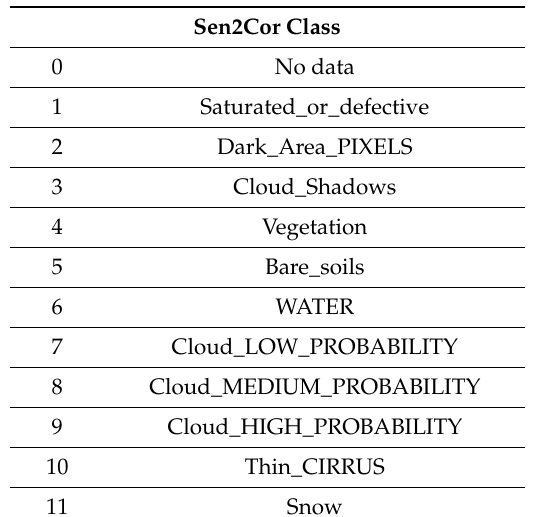
Table 2. Sen2Cor Scene classification classes for